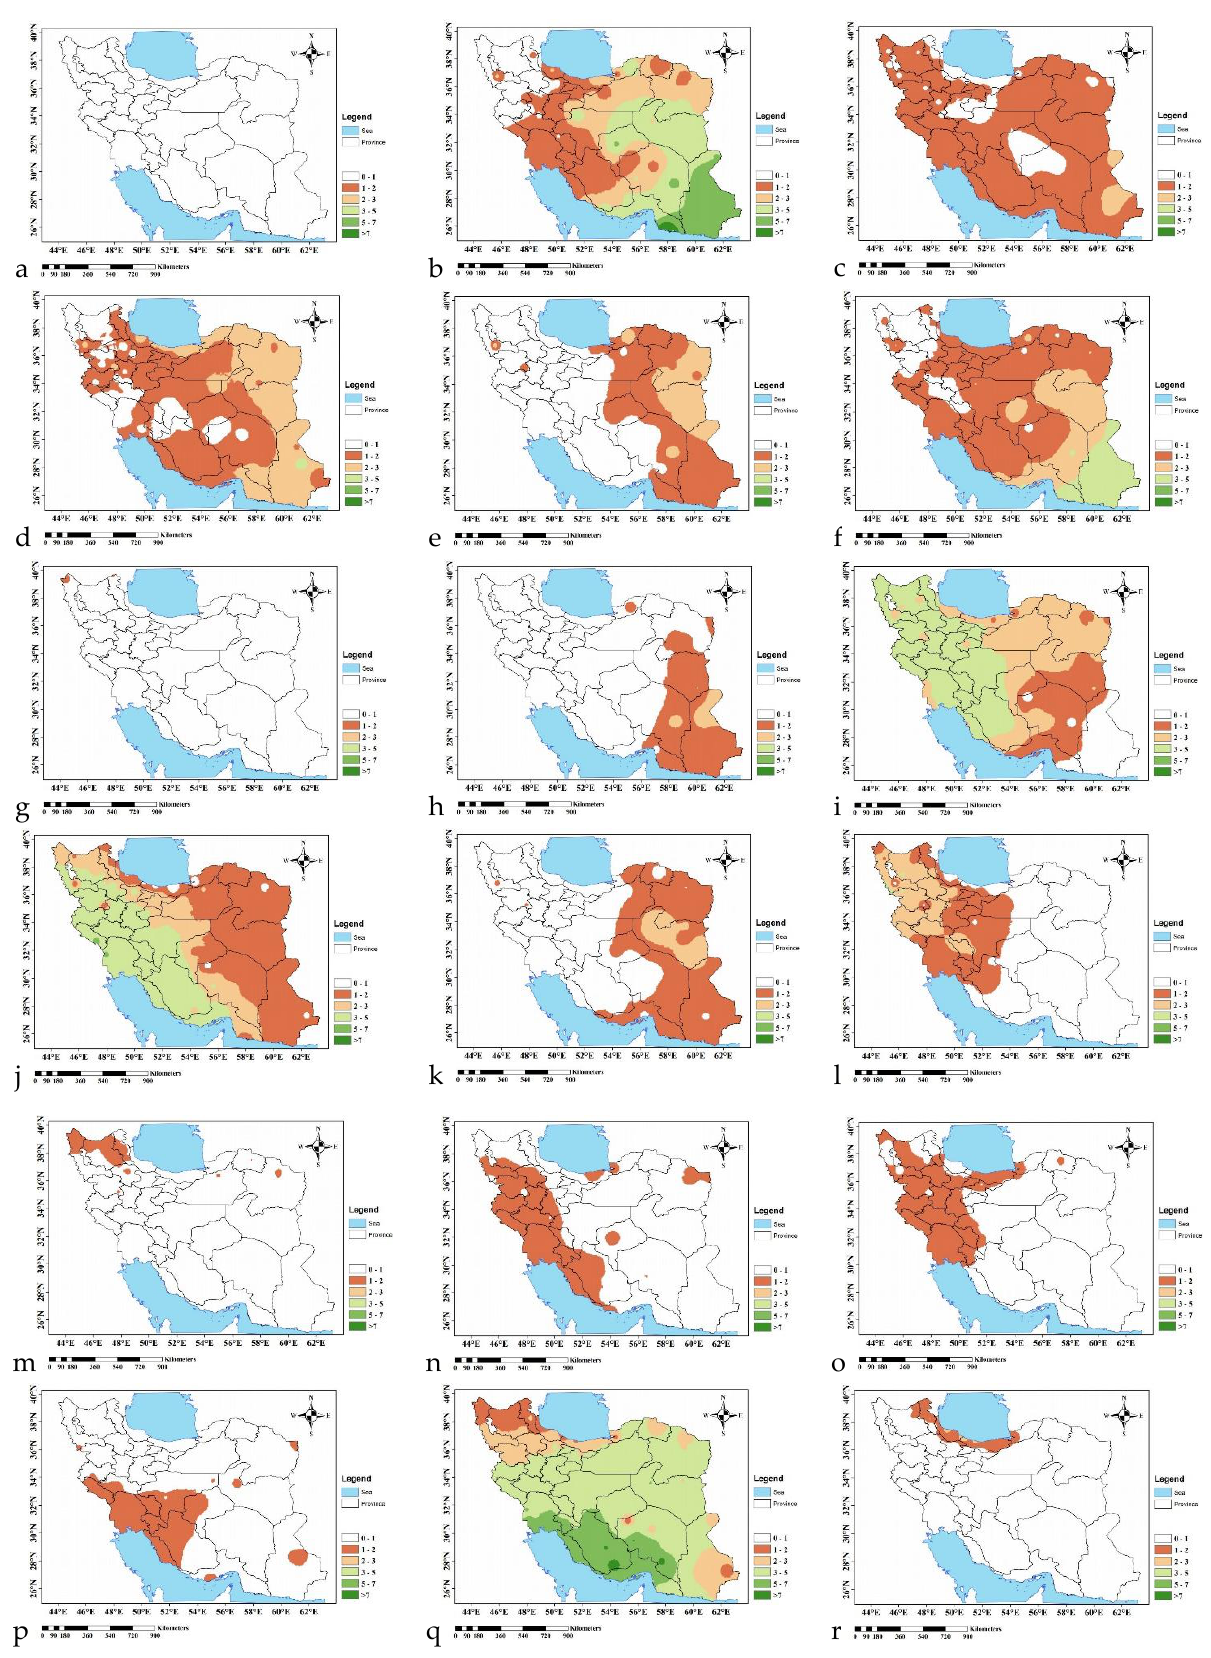
Figure 7. PI Index for patterns 1 – 18 ( a – r ), respectively.